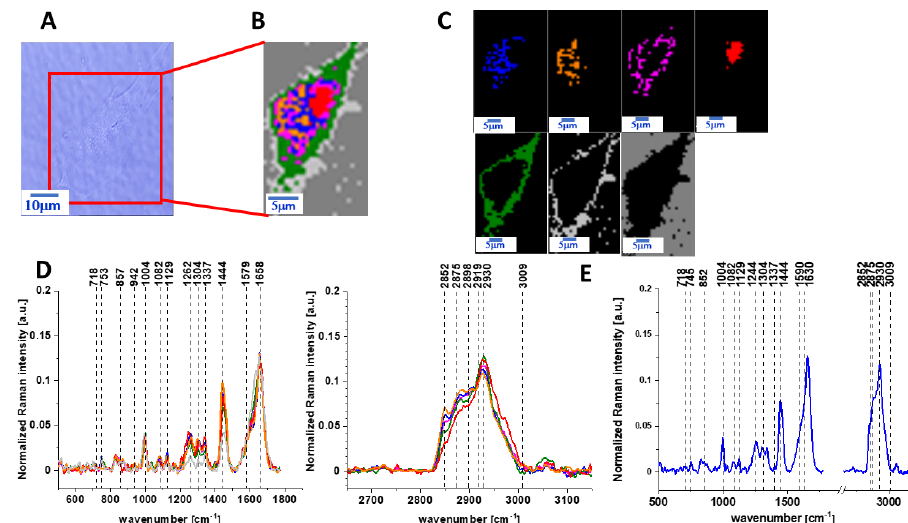
Figure 3. The microscopy image ( A ), Raman image ( B ) of human colon normal single cell CCD-18 Co after 48 h of vitamin C supplementation constructed based on cluster analysis (CA) method; Raman images of all clusters identified by CA assigned to lipid-rich regions (blue and orange), mitochondria (magenta), nucleus (red), cytoplasm (green), cell membrane (light grey), and cell environment (dark grey) ( C ); the average Raman spectra typical for CCD-18 Co human normal colon cell for all identified clusters for low frequency and high frequency region ( D ), and the average Raman spectrum for human normal colon cells—for cells as a whole ( E ), cells measured in PBS, colors of the spectra correspond to the colors of clusters; excitation laser line 532 nm; number of cells = 6.